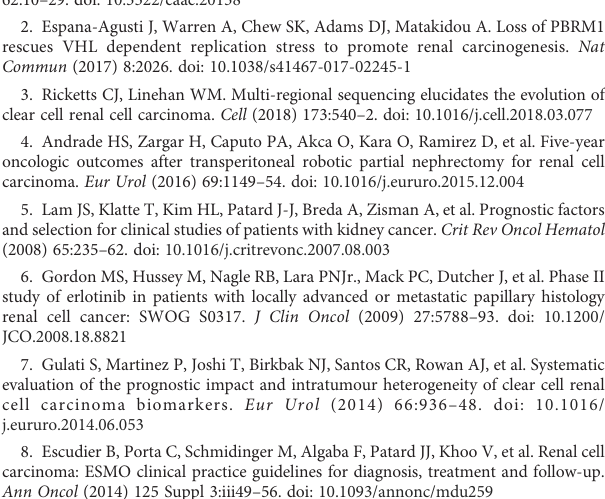
SUPPLEMENTARY FIGURE 1 Flow chart of the study population enrolment with inclusion and exclusion criteria. SUPPLEMENTARY FIGURE 2 Kaplan – Meier curves for overall survival in the training and validation cohorts. SUPPLEMENTARY FIGURE 3 Comparative evaluation of various models in the validation cohorts. (A-J) Calibration plots describing the calibration of six models based on the consistency between predicted and observed 5-year OS results. (K-S) Clinical Impact Curve (CIC) of six models in the validation cohort. The red curve (Number high Risk) represents the number of people classi fi ed as positive (high risk) by the model at each threshold probability; The blue curve (Number high risk with outcome) is the Number of true positives at each threshold probability. SUPPLEMENTARY FIGURE 4 The relationship between radiomics and genomics in CPTAC. (A) Hierarchical clusteringof30DEGsofRCC. (B) KEGGpathwaysanalysisofDEGsassociated with radiomics signature. (C) A volcano plot generated using the data of differentially expressed genes (DEGs) between high-risk and low-risk groups from CPTAC. SUPPLEMENTARY FIGURE 5 Sensitivity analysis for the consistency of radiomics features. (A) Histogram of Pearson r values calculated from the radiomic features between the initial dataset and repeated dataset. (B-L) Bland-Altman plots were used to test the potential agreement between two observers. Mean difference (dashed line) is close to zero, showing no bias; solid black lines delimit limits of agreement (95%